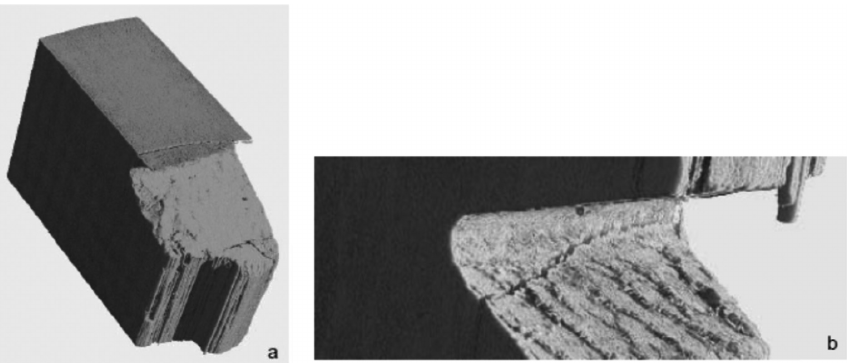
Fig. 11. Side view indicating the relative positioning of crack (a) and notch and crack intersection with the notch (b).